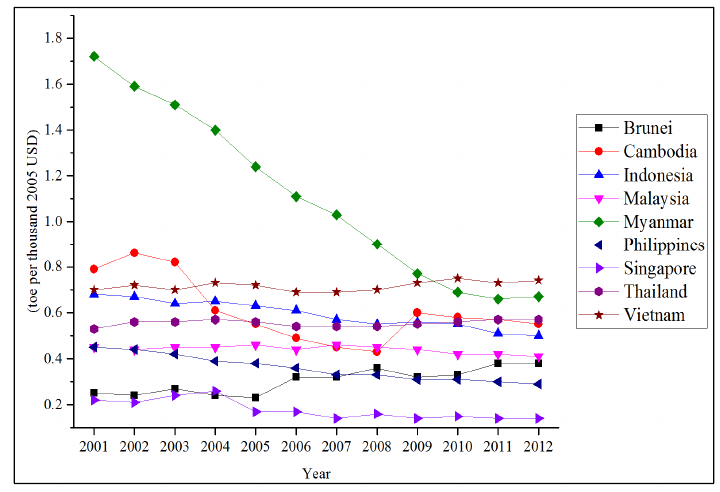
Figure 28. Energy intensity